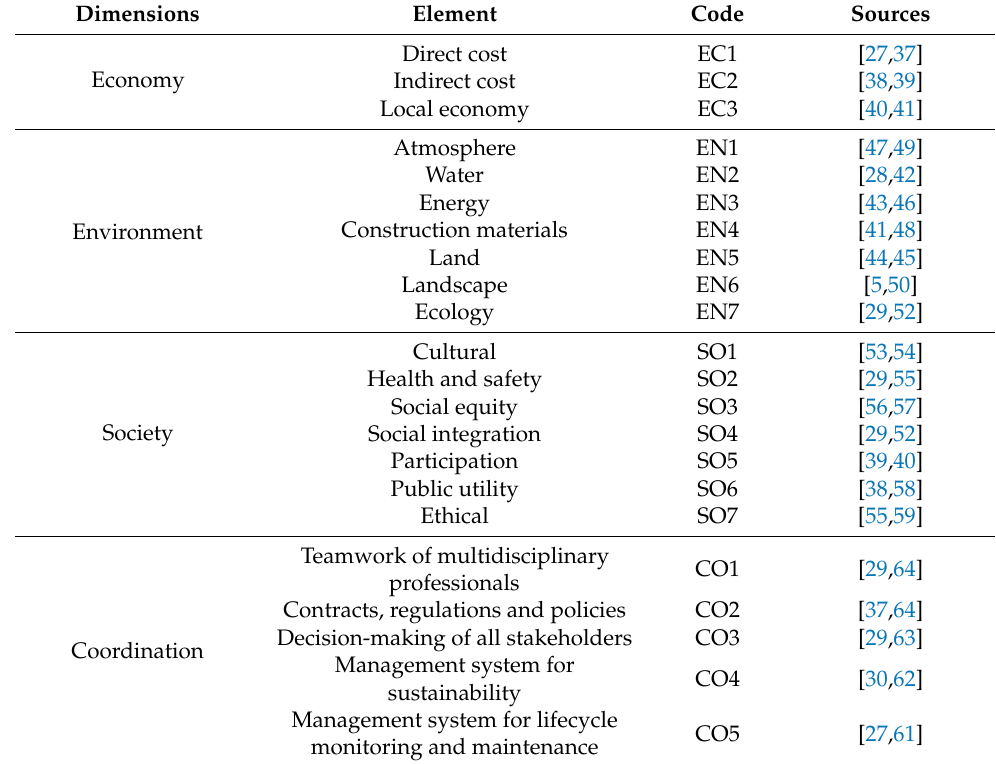
Table 3. The key elements of sustainable